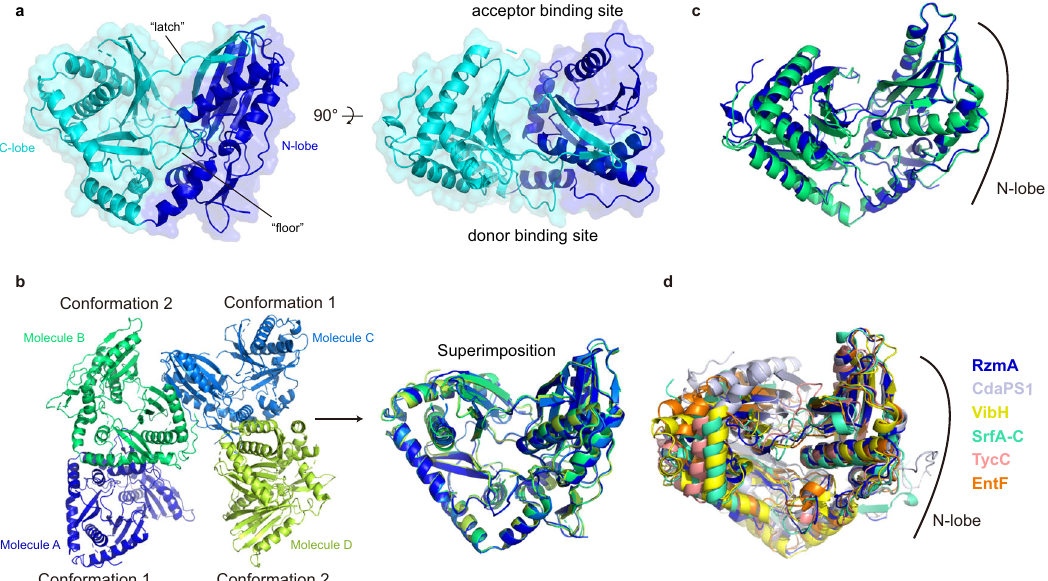
Fig. 5 The overall structure of the RzmA-Cs domain. a RzmA-Cs consists of N-lobe (blue) and C-lobe (cycan), and the C-lobe has two regions expanding to N-lobe, named as “ latch ” (residues 349 – 369) and “ fl oor ” (residues 274 – 287) 39 . b Four molecules of RzmA-Cs in each asymmetric unit with two conformations. c Comparison of two conformations of RzmA-Cs by overlaying the N-lobe. d Superimposition of C domains in six NRPSs, RzmA (PDB: 7C1H), CdaPS1 (PDB: 4JN5), VibH (PDB: 1L5A), SrfA-C (PDB: 2VSQ), TycC (PDB: 2JGP), and EntF (PDB: 5JA1), by their